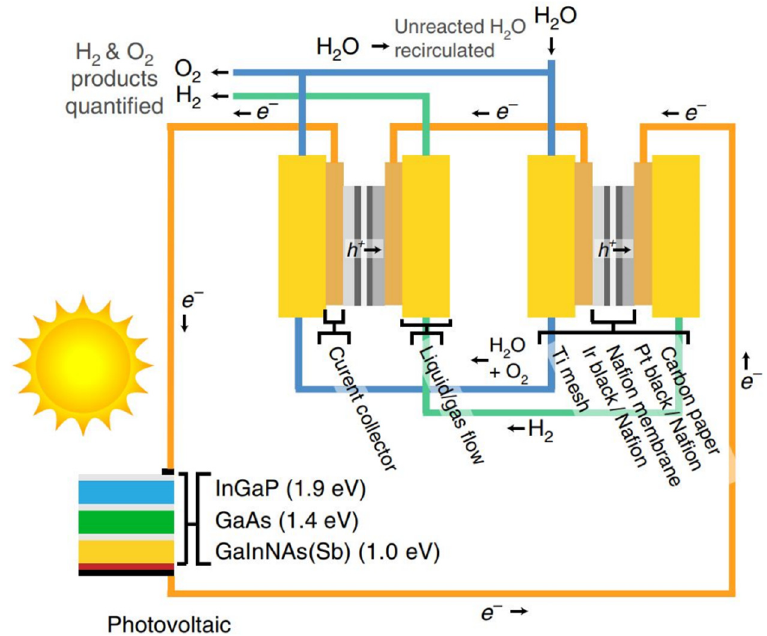
Figure 15. Schematic of PV-electrolysis system for hydrogen production [249].